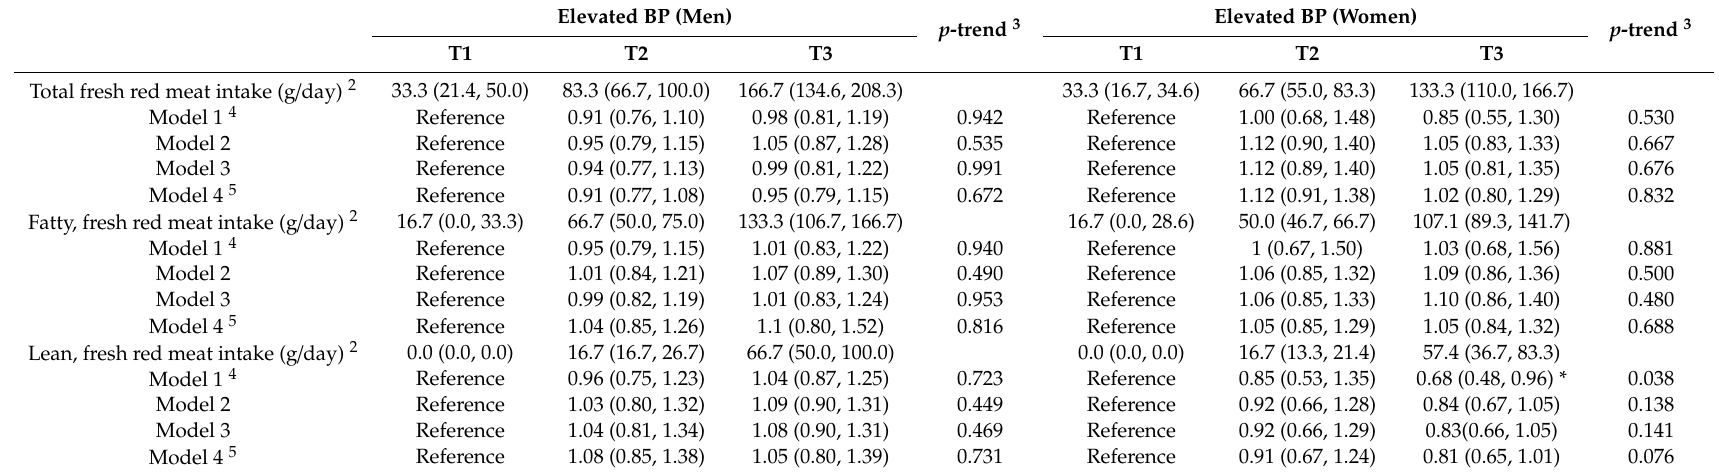
Table 4. Odds ratio (95% CI) of elevated BP according to three levels of intake of total fresh red meat and its subtypes among Chinese adults, CHNS